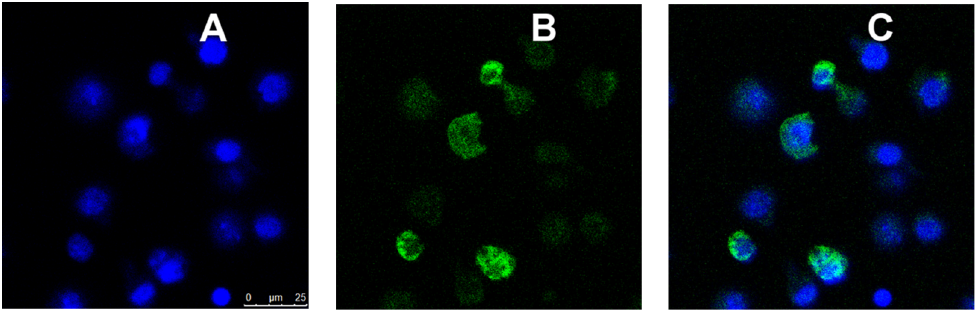
Figure 8. Confocal microscopic images of M2 MPs treated with FITC-labeled MRTL 1% -NPs. Activated M2 MPs were inoculated into coverglass chambers and analyzed by confocal microscopy, conducted in the XYZ mode. A middle section of 0.5 µ m thickness in a Z stack is shown. ( A ) DAPI (blue) fluorescence image. ( B ) FITC (green) fluorescence image. ( C ) Blue and green merged images. The green NPs are within the cells, with no significant cell surface